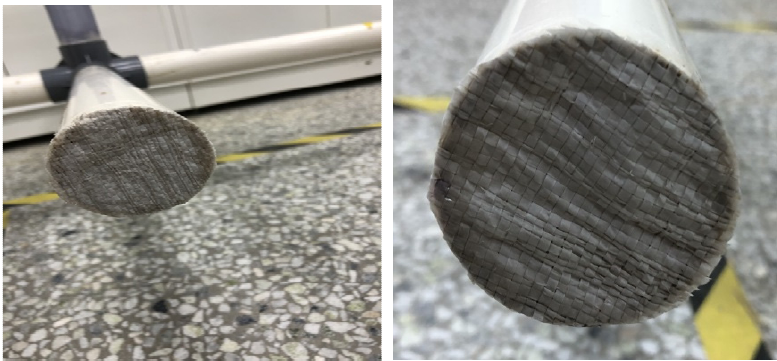
Figure 14. An arrangement of simulated geotextile for the fiber bundle drainage pipe.